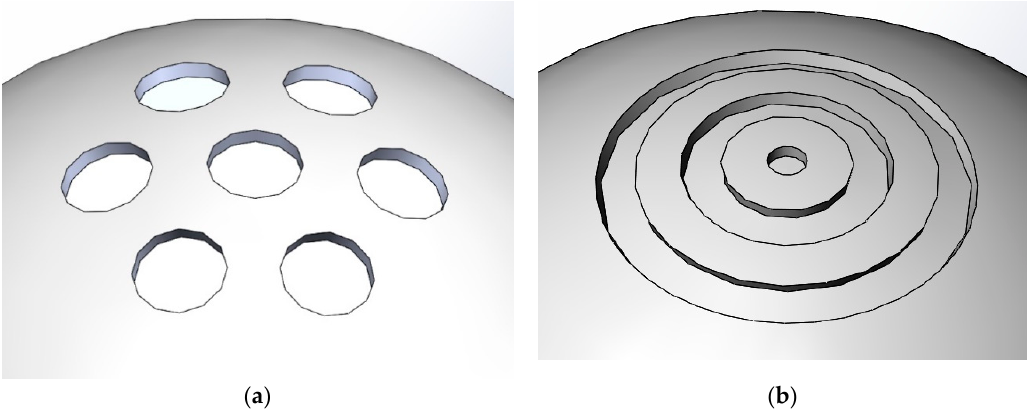
Figure 3. Selection of the features for the ball head; ( a ) hole shape; ( b ) groove shape.